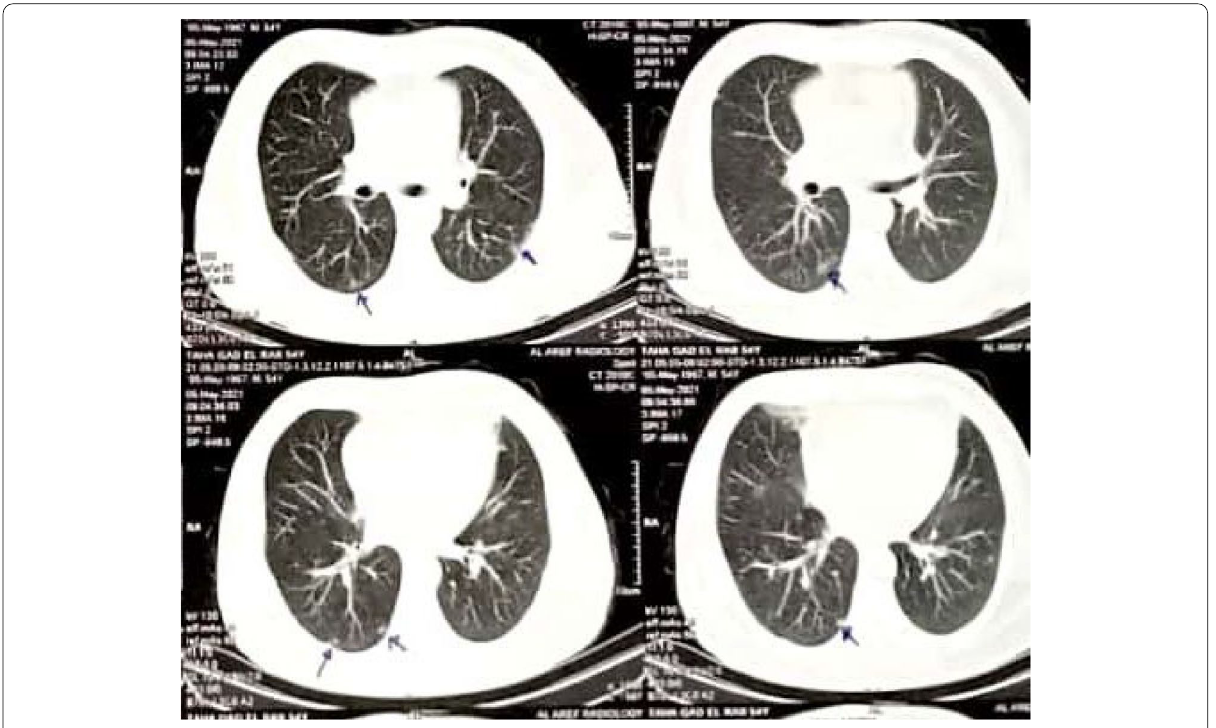
Fig. 1 Bilateral small-sized peripheral ground glass opacities in both